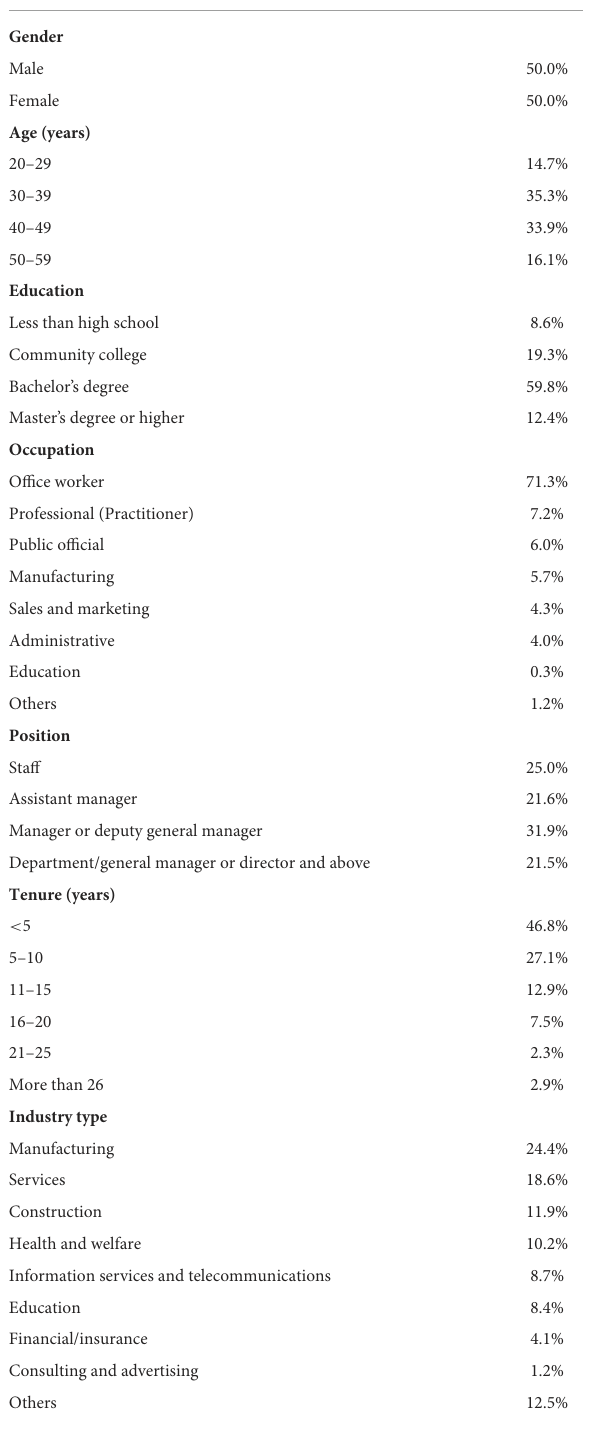
TABLE 1 Descriptive characteristics of the study